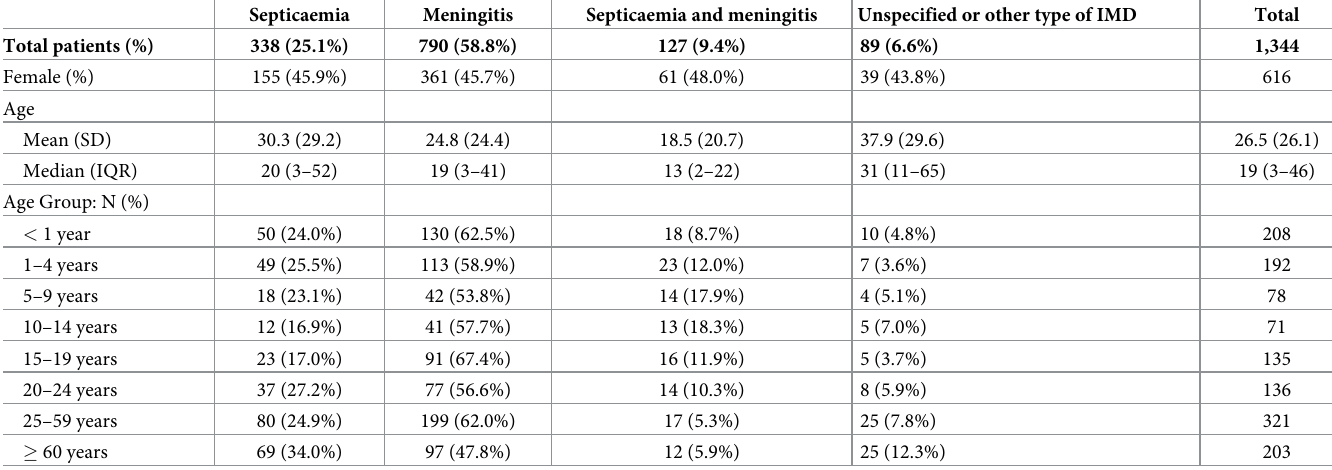
Table 1. Characteristics of IMD patients by clinical manifestations during